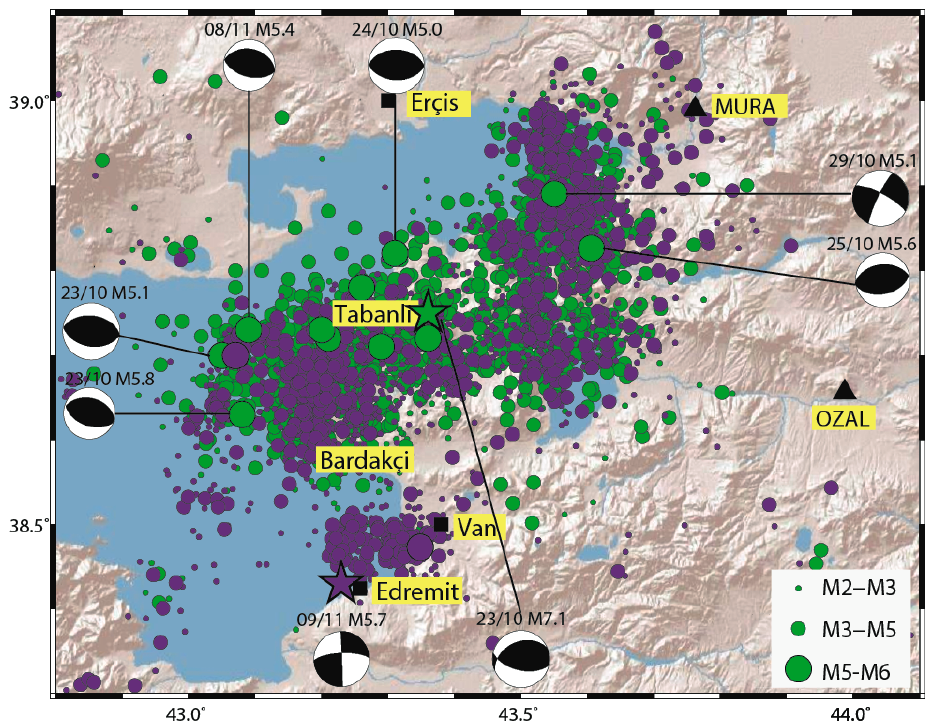
Figure 1. Map of the Mw 7.1 Van earthquake (green star) and related aftershocks until the end of 2011. The Edremit-Van earthquake epicenter is indicated with the purple star. The aftershocks (green before the Edremit-Van earthquake, purple after) are from [2] and KOERI. The available focal mechanisms of M > 5.0 events from Global-CMT earthquake catalog and [3] are shown. Near field GPS stations (MURA and OZAL) are indicated by black triangles.